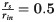
Comparison of the temperature fields at the middle of simulation (t = 0.5s) (a) the case with rsrin=0.5 (b) the case with rsrin=0.6.